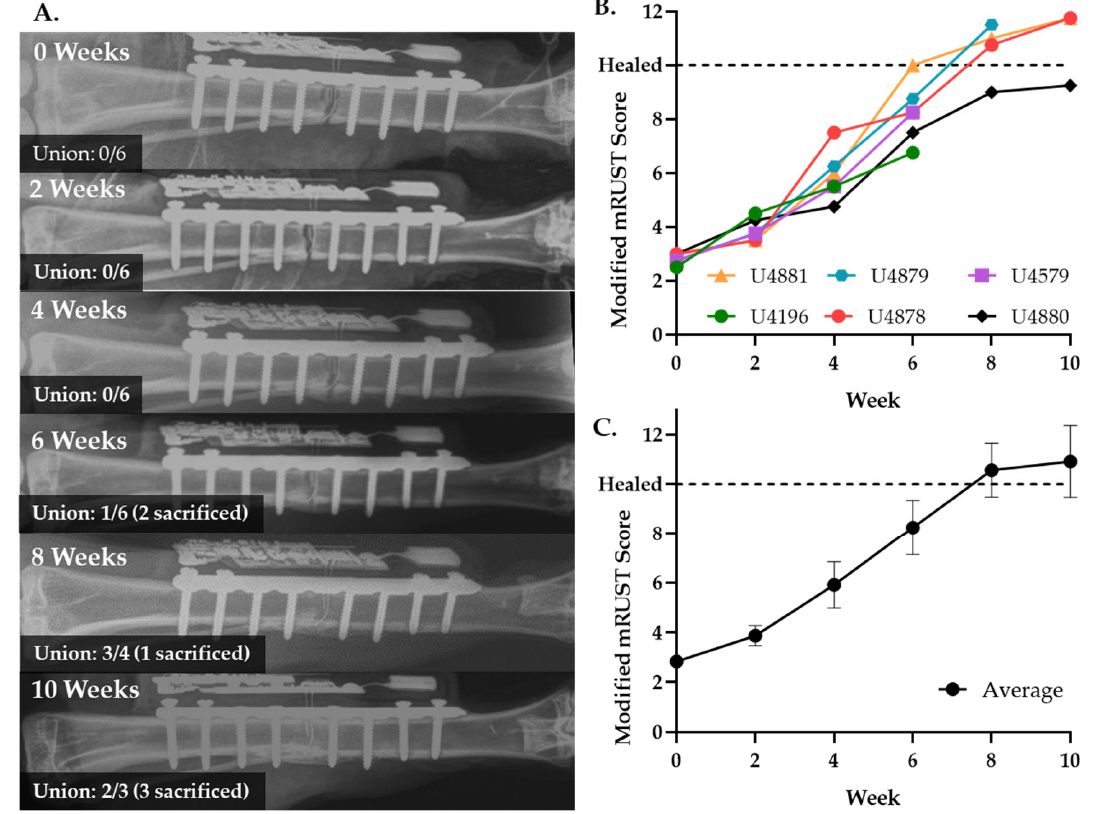
Figure 3. Rabbit tibiae healing by ~8 weeks with EIS smart bone plate. ( A ) Representative X ‐ rays of healing weeks 2–10 weeks post ‐ operatively. ( B ) Radiographic healing scores from individual ani ‐ healing weeks 2–10 weeks post-operatively. ( B ) Radiographic healing scores from individual animals. mals. ( C ) Average radiographic healing scores over time. ( C ) Average radiographic healing scores over